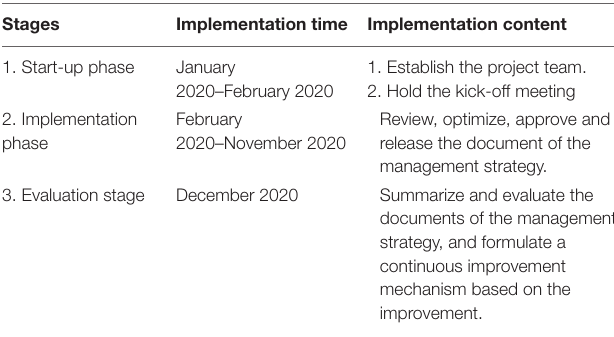
TABLE 1 | Implementation plan of the management strategy of new venture